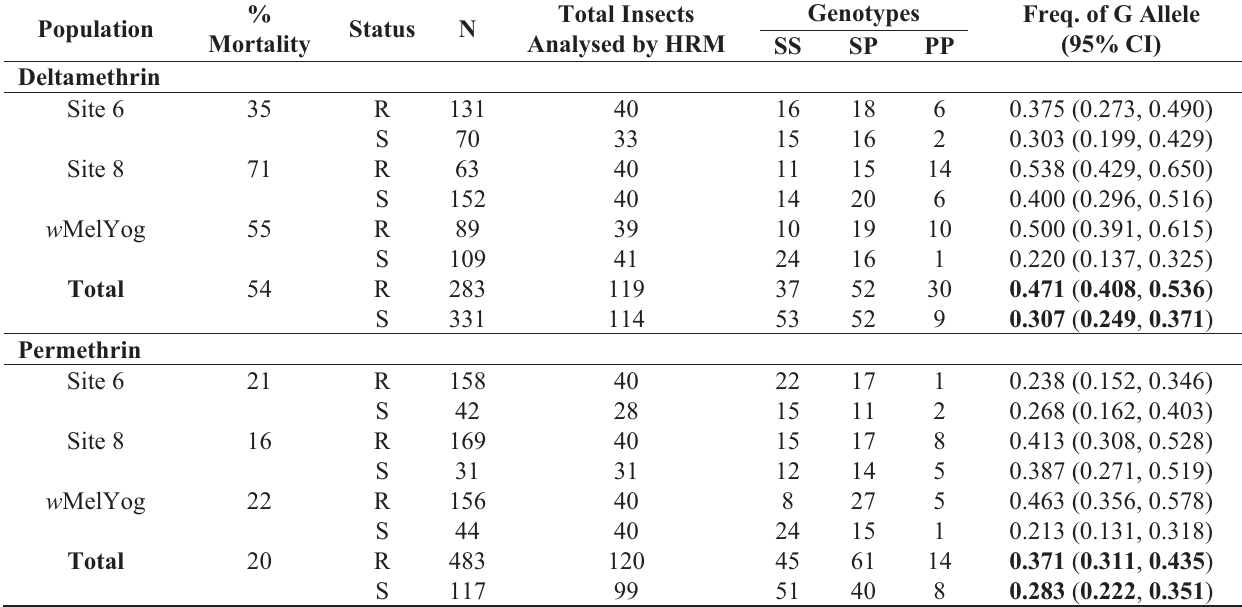
Table 8. Genotypes and allele frequencies of Vssc mutation S996P in Aedes aegypti mosquito samples from Yogyakarta assayed with deltamethrin and permethrin.